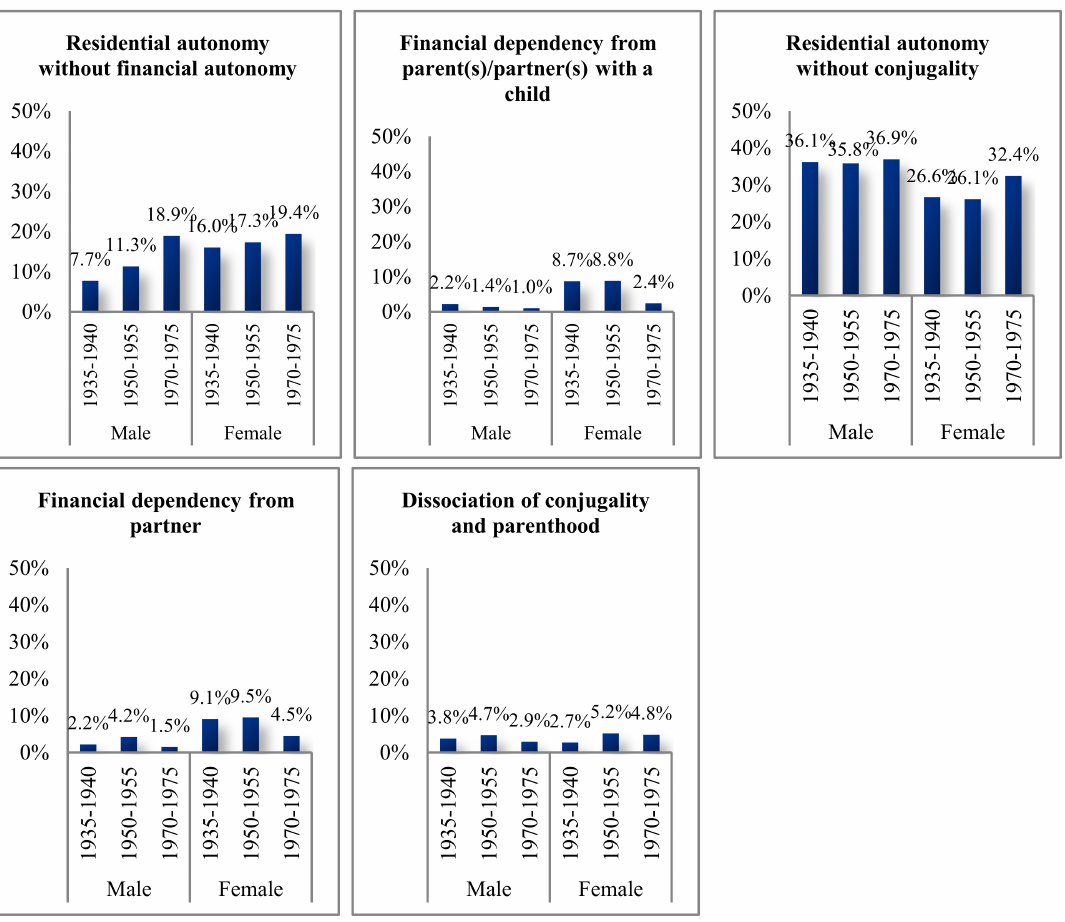
Figure 3. Changes to the normative order of transitions by sex and